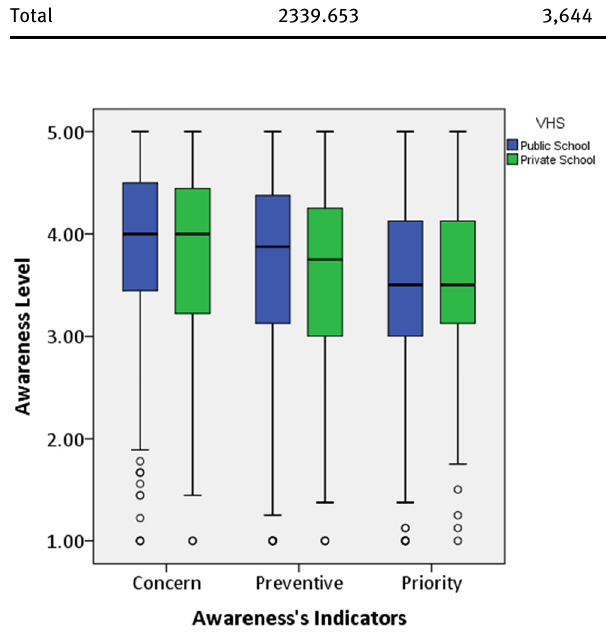
Figure 12: Student ’ s awareness level by public school and private school.